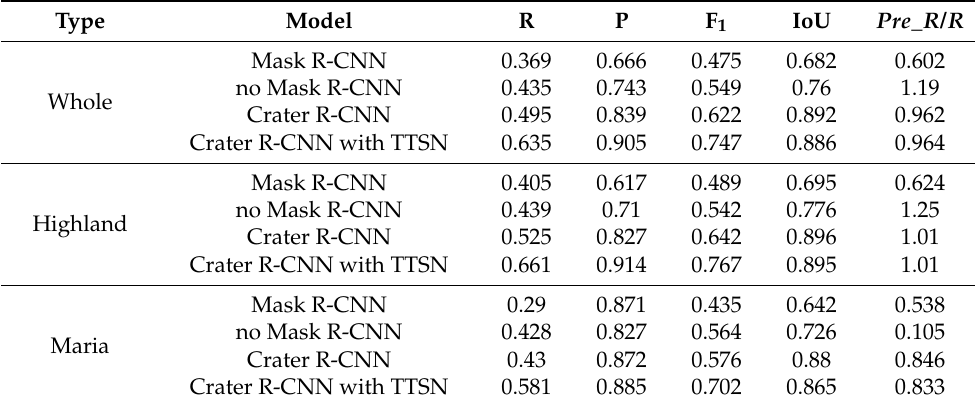
Figure 12. Detection accuracy under different radii: ( a – c ) show the precision, recall, and F 1 of the four methods in whole test set, respectively. Table 4. Accuracy evaluation for different crater detection